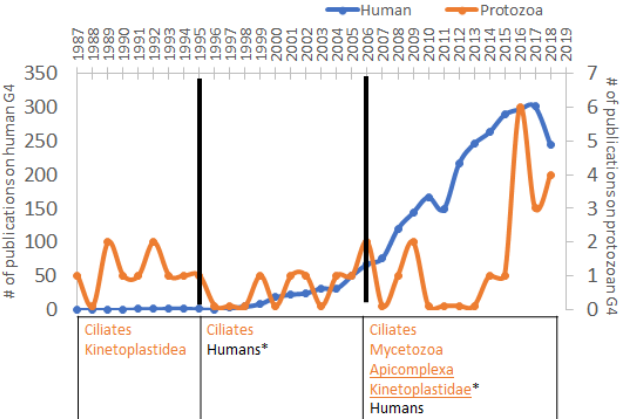
Figure 2. Compared evolution of the number of G4 publications related to protozoa and humans across time. Data were extracted from PubMed on 20/02/19 using the search terms “G-quadruplex human”, “G4 humans” and “Guanine quadruplex humans”, then compared to eliminate duplicates. The protozoan literature count is derived from the publications reviewed here, which represent the totality of the work available so far in the field. Orange line and taxa represent the protozoan data and the blue ones represent the human data. Underlined taxa include studies of human pathogens. * represents clades where rG4 work is available.